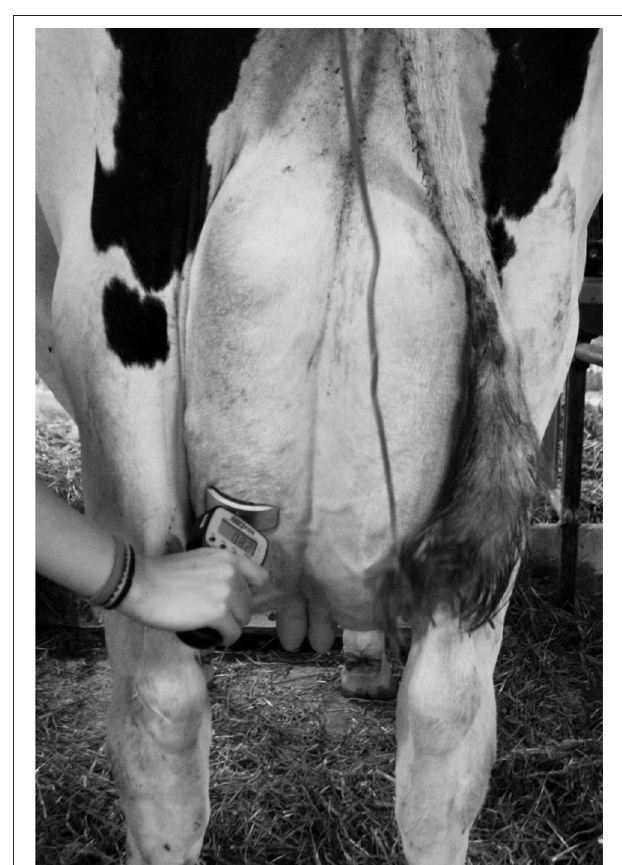
FIGURE 1 | Illustration of the placement of a pressure algometer for quantifying mechanical nociceptive threshold in dairy